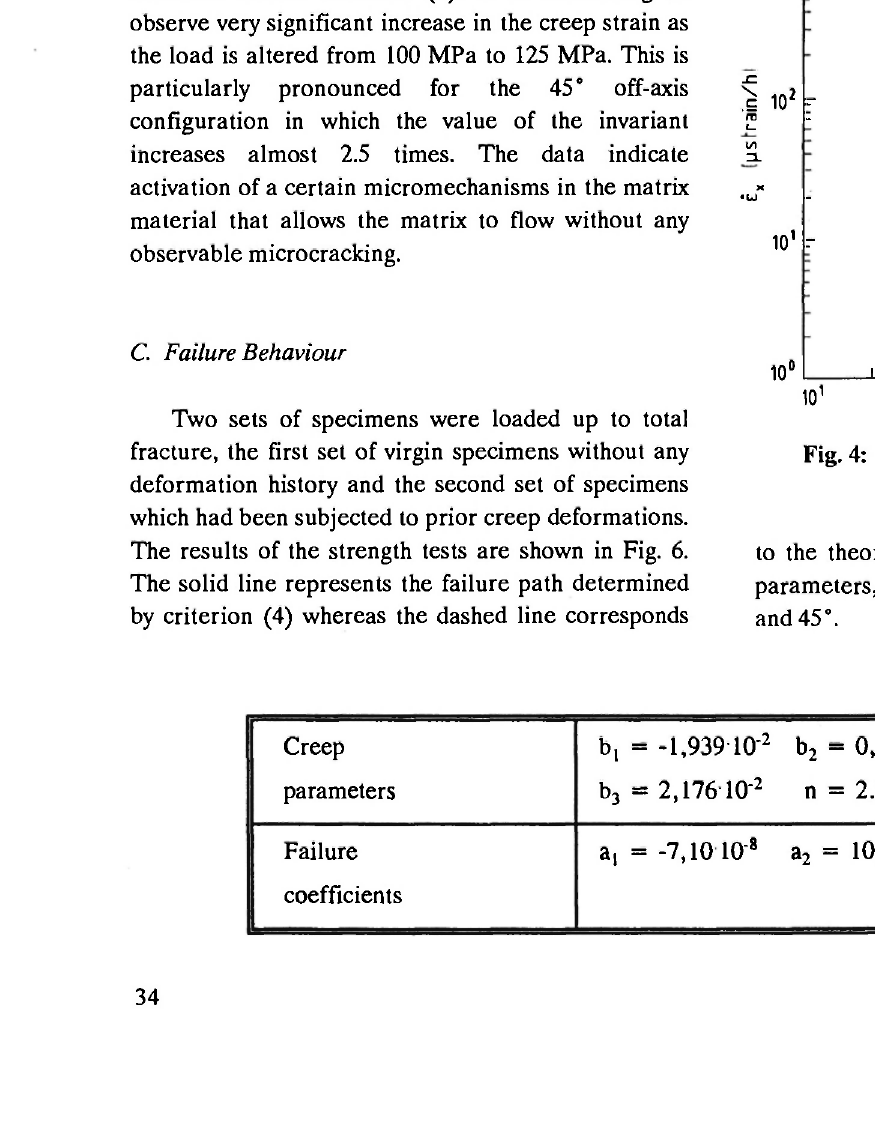
Fig. 4: Off-axis creep rate in uniaxial tension